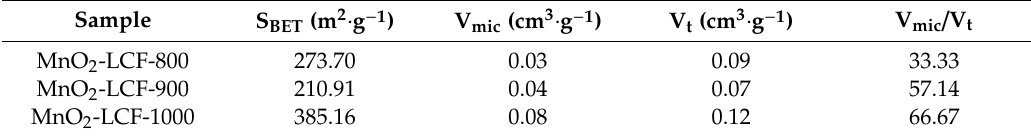
Table 1. Brunauer–Emmett–Teller (BET) analysis of the MnO 2 -LCF samples.